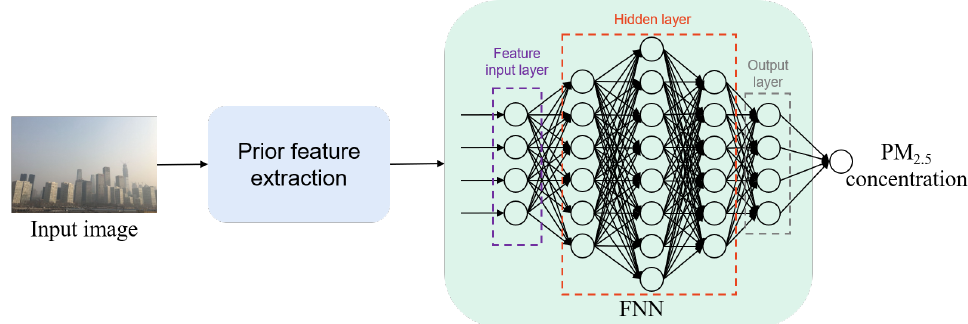
Figure 4. The framework of our proposed PM 2.5 concentration measurement